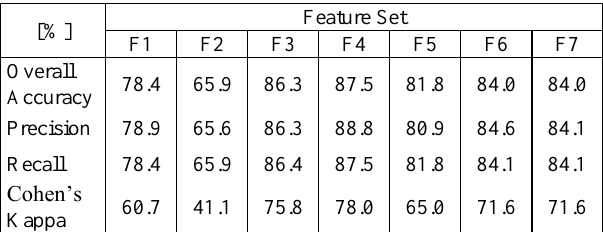
Table 4. Results of classification for the “cleaned” data set,